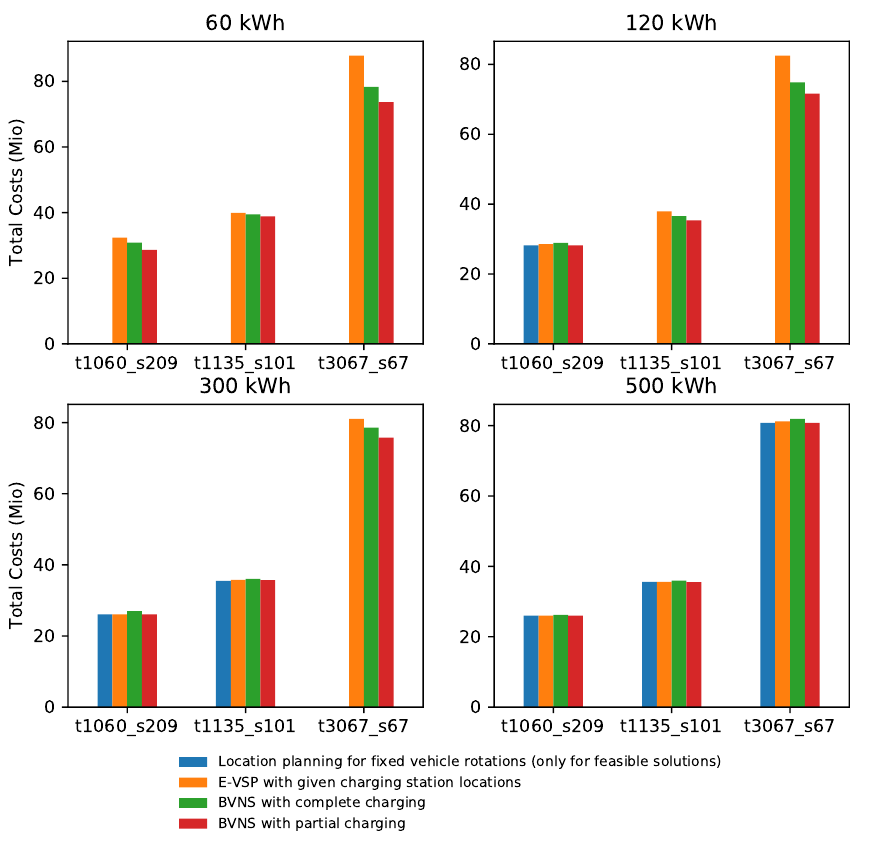
Figure 3. Overview of total costs obtained by the different solution approaches presented for all battery